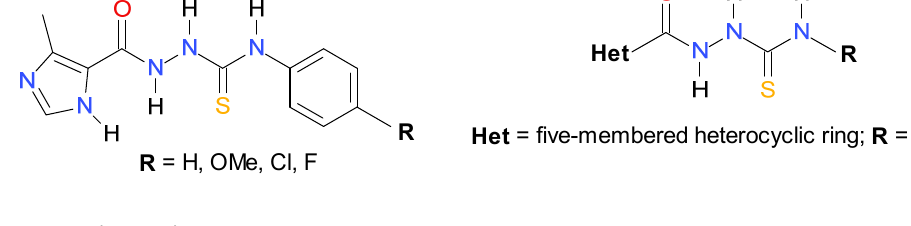
Figure 1. Left: Structures of 4-aryl-1-(4-methyl-1H-imidazole-5-yl)carbonylthiosemicarbazides with more potent anti- Toxoplasma gondii activity than the standard drugs sulfadiazine and hydroxyurea [21]; and right: Structures of title